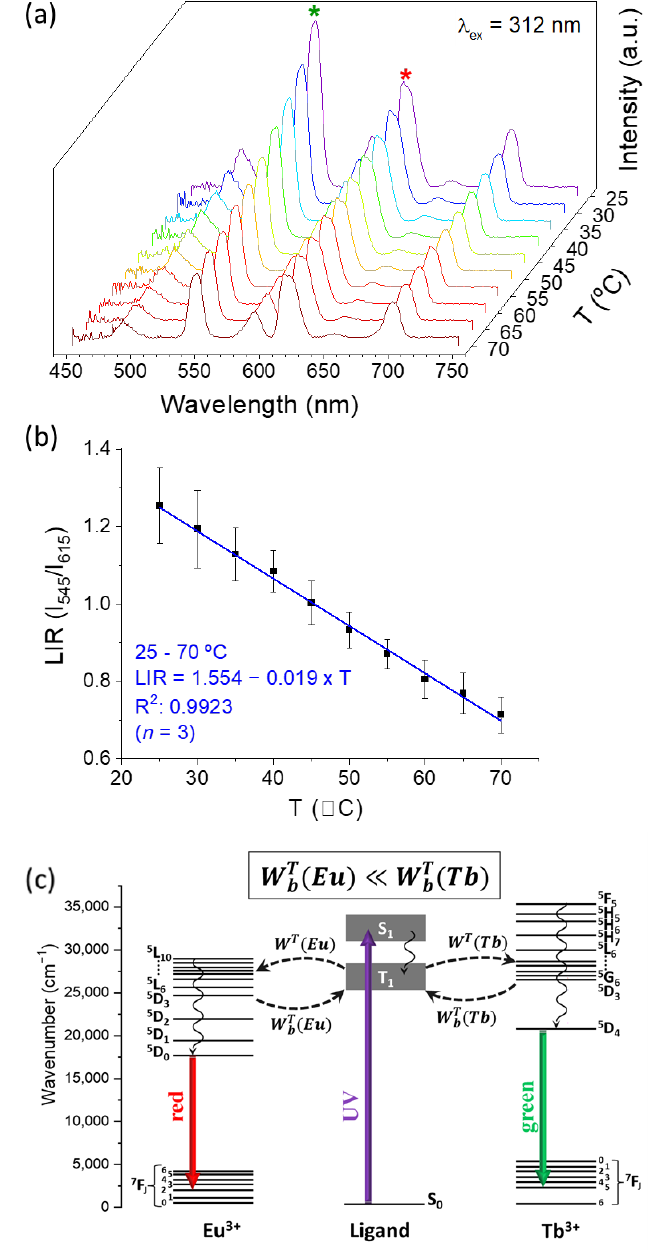
Figure 6. ( a ) Emission spectra of IONP@SiO 2 - acac -Ln 3+ ( λ ex = 312 nm) recorded at temperatures between 25 and 70 ◦ C. The green and red asterisk symbols indicate the Tb 3+ : 5 D 4 → 7 F 5 (530–565 nm) and Eu 3+ : 5 D 0 → 7 F 2 (603 – 637 nm) transitions, of which integrated areas were used to construct ( b ) the calibration curve LIR vs. temperature. The solid line represents a linear fitting. The error bars correspond to standard error of mean determined from three consecutive temperature cycles. ( c ) Simplified energy level diagram showing the intra-4f transitions observed in Figure 5b and the effect of the increase of the backward IET rates with the temperature; see SI for further details on the IET calculations.